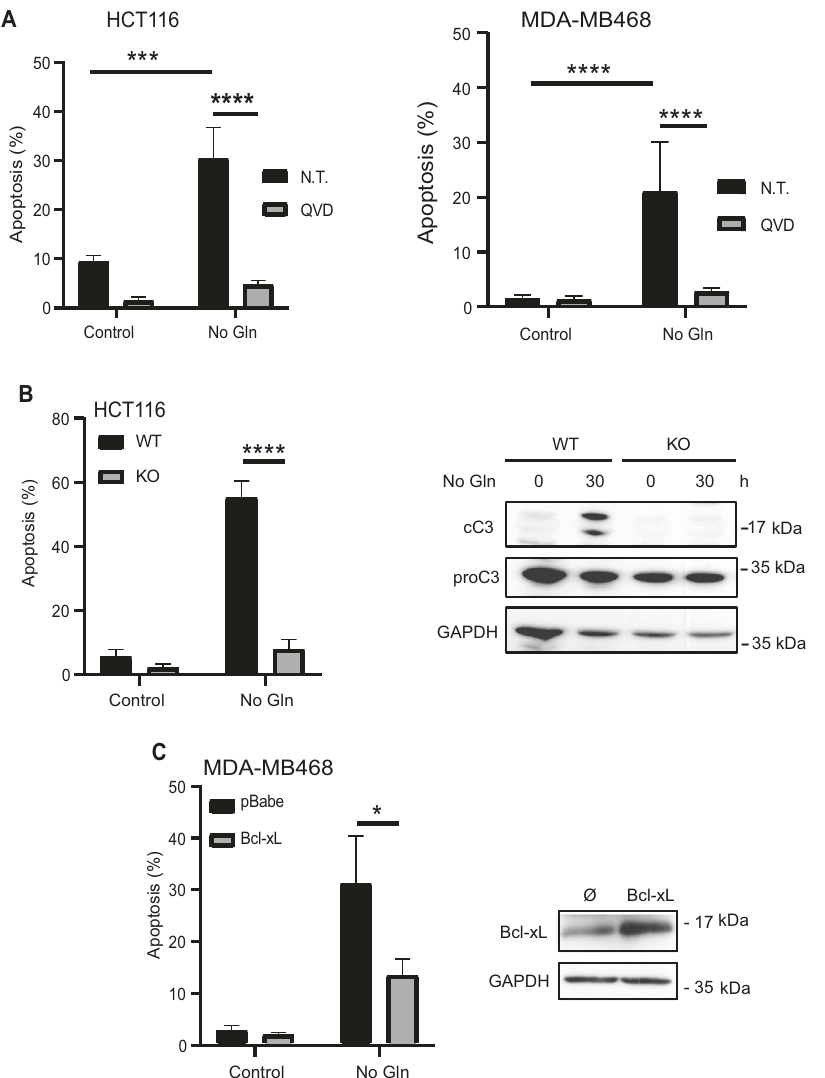
Fig. 1 Glutamine deprivation induces apoptosis in tumor cell lines of different origins by a mitochondria-operated pathway. A HCT116 (left) or MDA-MB468 (right) cells were cultured for 48 h in medium with or without glutamine (Gln) in the presence or absence of Q-VD-OPh (20 µmol/L). Apoptosis was determined as described in Materials and Methods section. B Apoptosis was assessed in HCT116 WTor Bax/Bak KO cells cultured in the presence or absence of glutamine for 48 h (left panel). Procaspase-3 (proC3) and cleaved caspase-3 (cC3) levels